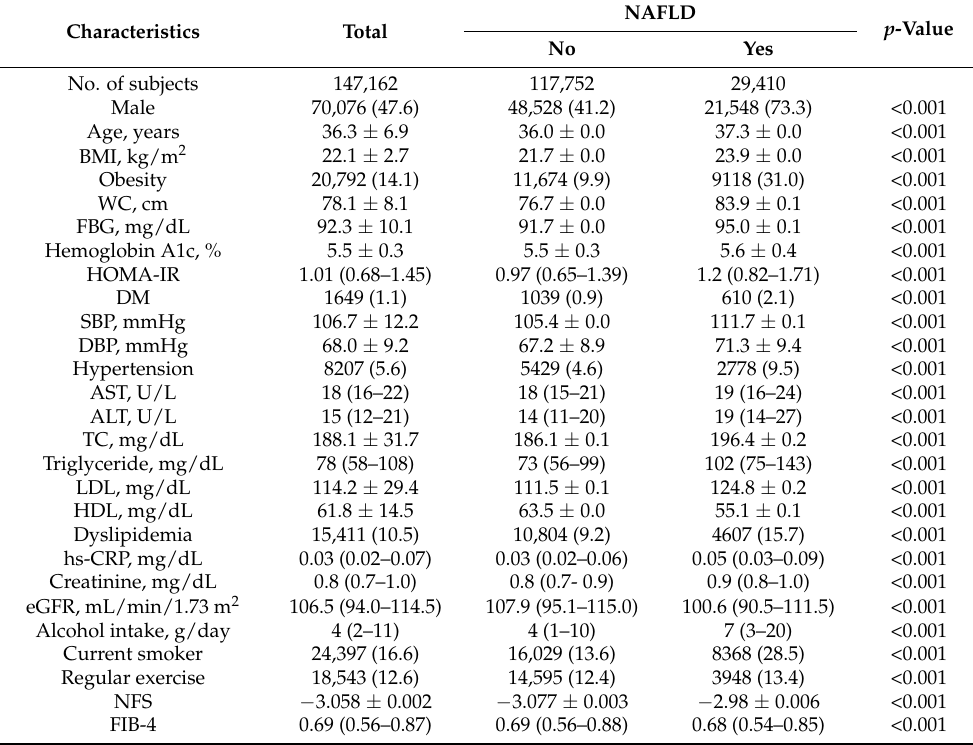
Table 1. Baseline characteristics of participants according to the development of NAFLD at the end of the